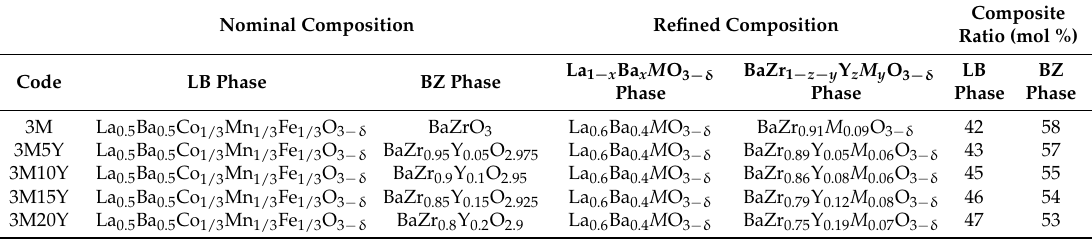
Table 1. Nominal composition and the nomenclature of the series of 3 M nanocomposite cathodes are presented. Refined composition and the ratio of the composite were obtained from XRD Rietveld